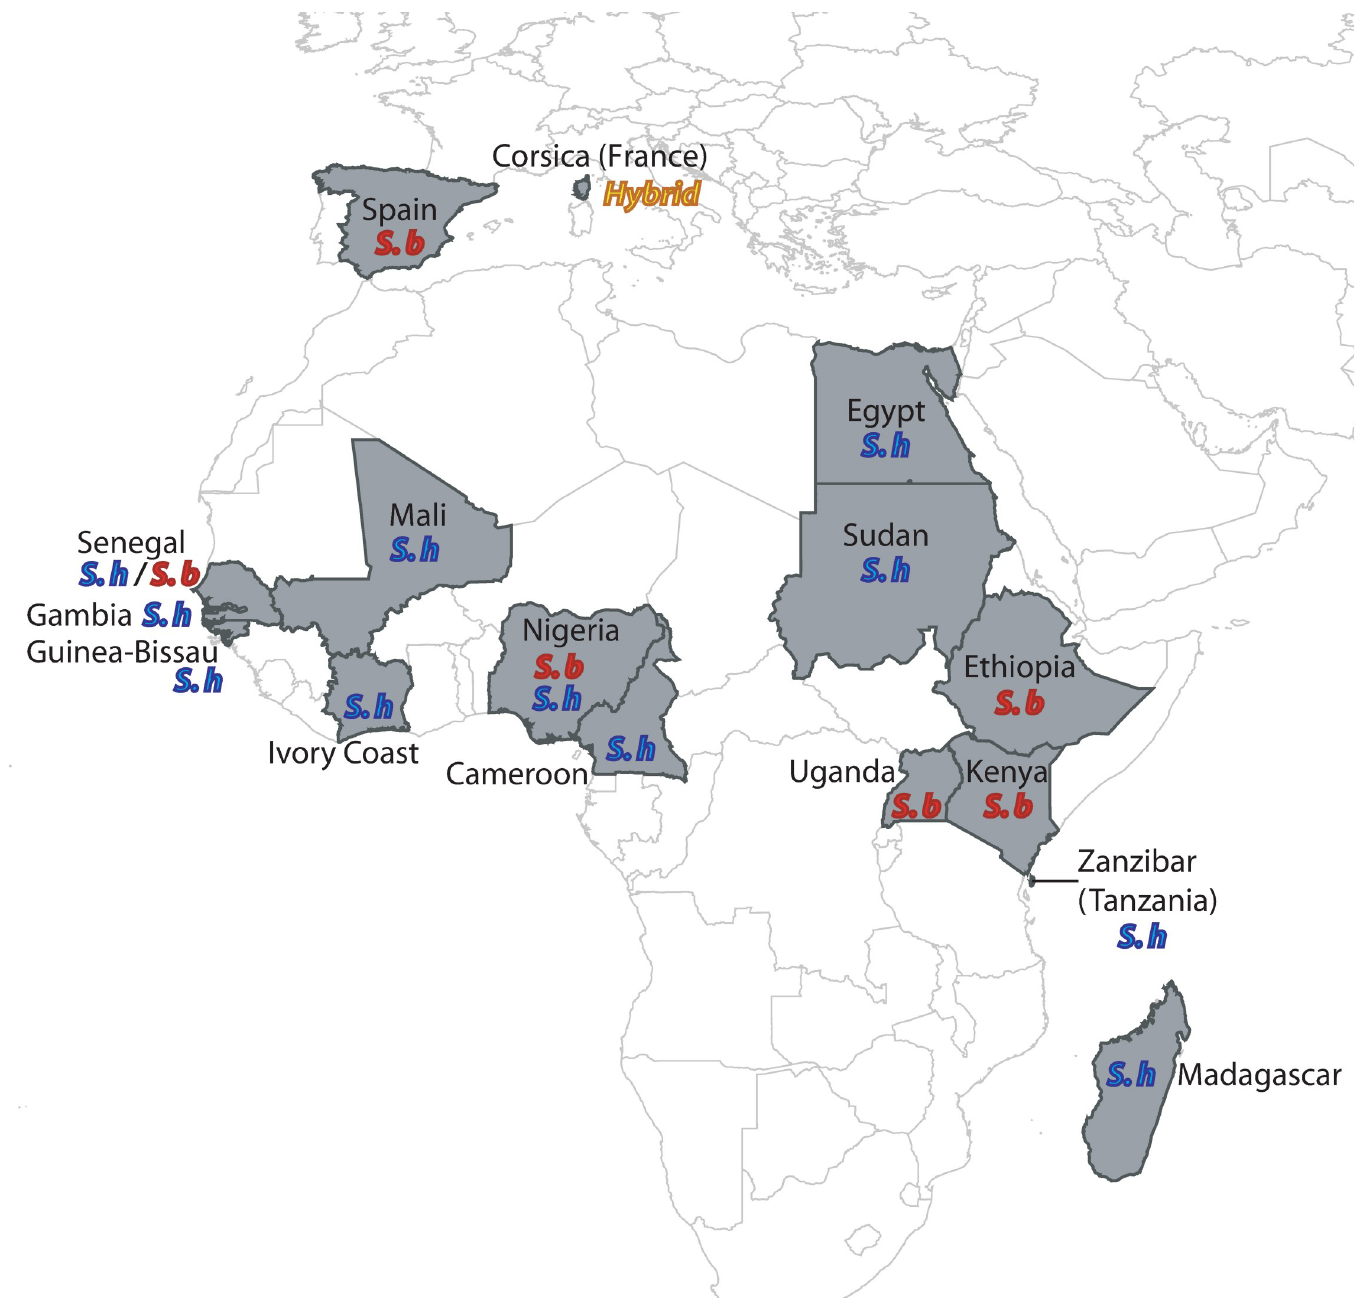
Fig 1. Geographical origins of the S . haematobium (S. h), S . bovis (S. b) and hybrid samples analyzed in this study.